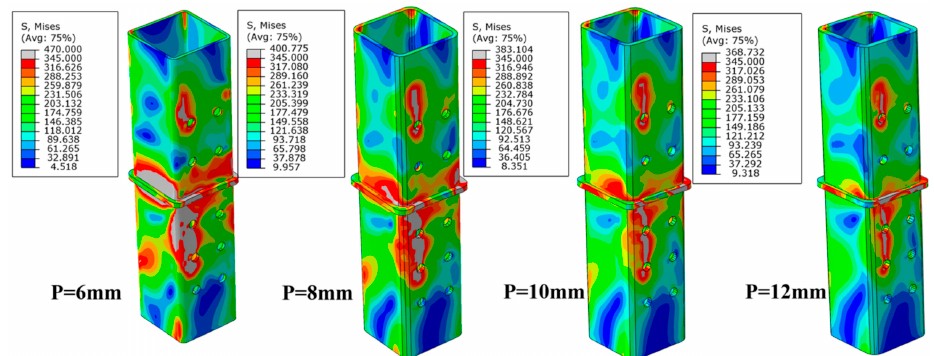
Figure 20. Stress distribution of inbuild component with different thickness.